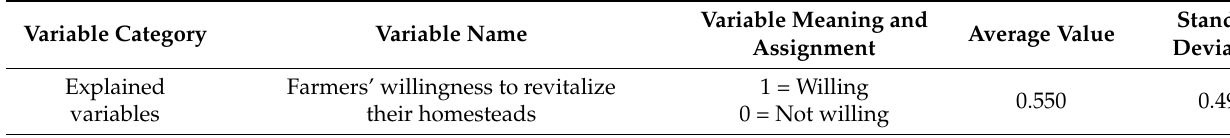
Table 2. Specific meaning of variables and results of descriptive statistical